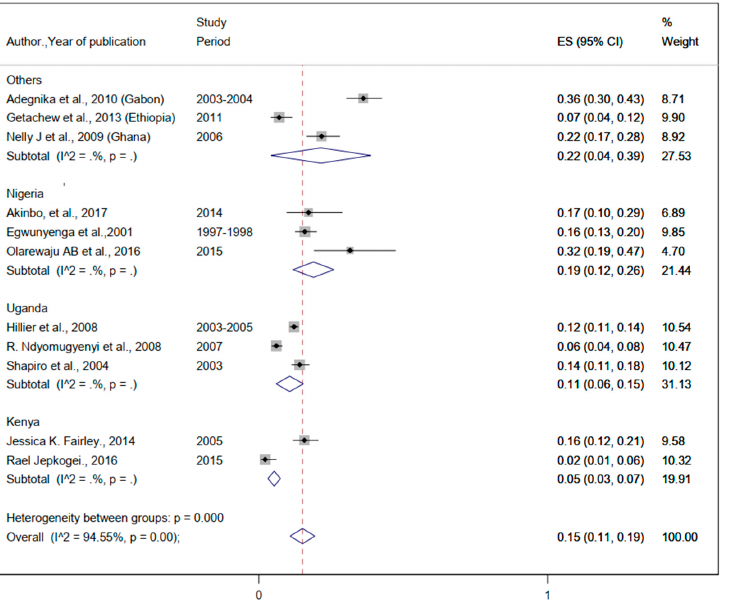
Figure 6. The proportion of Ascaris lumbricoides estimated from the overall helminthic infection among pregnant women in sub-Saharan Africa.